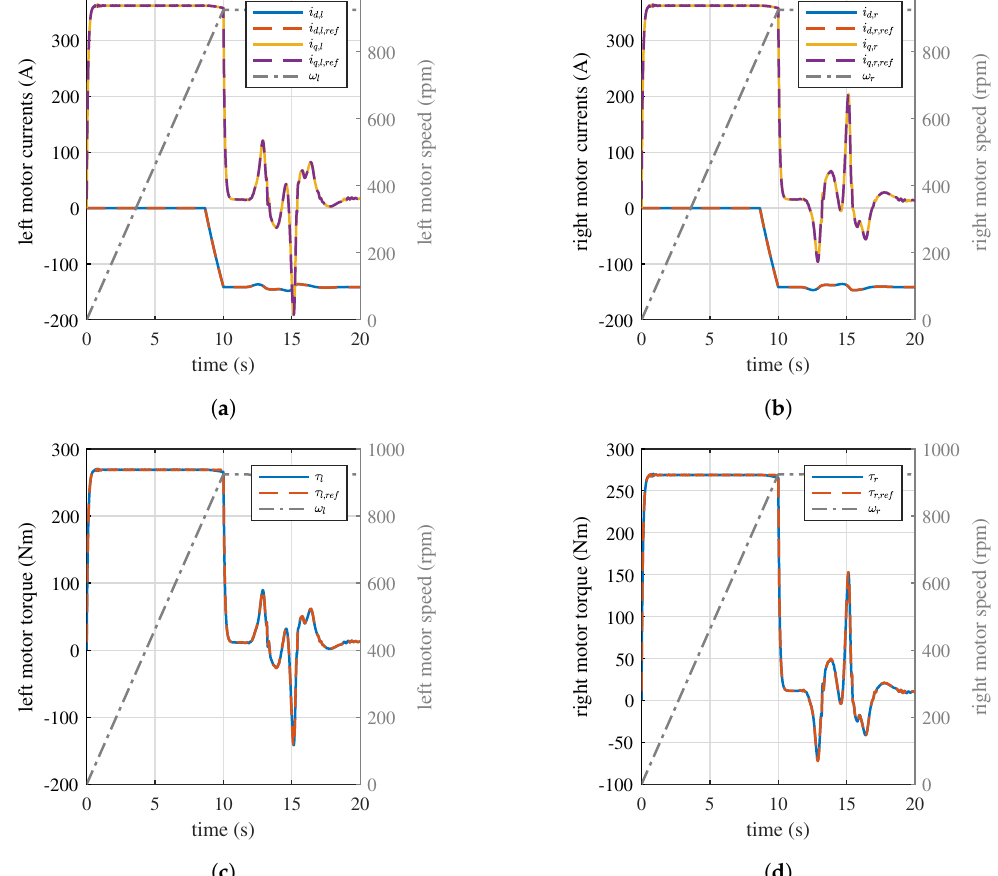
Figure 11. Time histories of the current–controlled electric motors. Measured signals (solid) are compared to the references (dashed). ( a ) Left motor: direct– and quadrature–axis currents. ( b ) Right motor: direct– and quadrature–axis currents. ( c ) Left motor: torque and angular speed. ( d ) Right motor: torque and angular